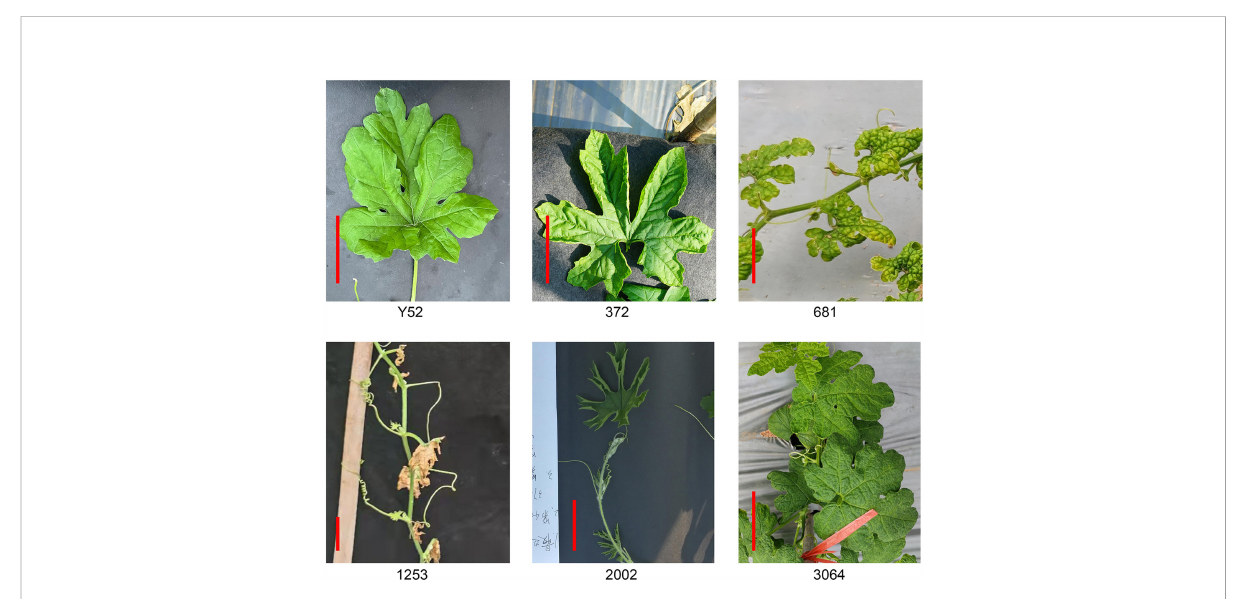
FIGURE 3 Mutants with a variety of leaf shapes compared to Y52. Scale bar in red color = 5